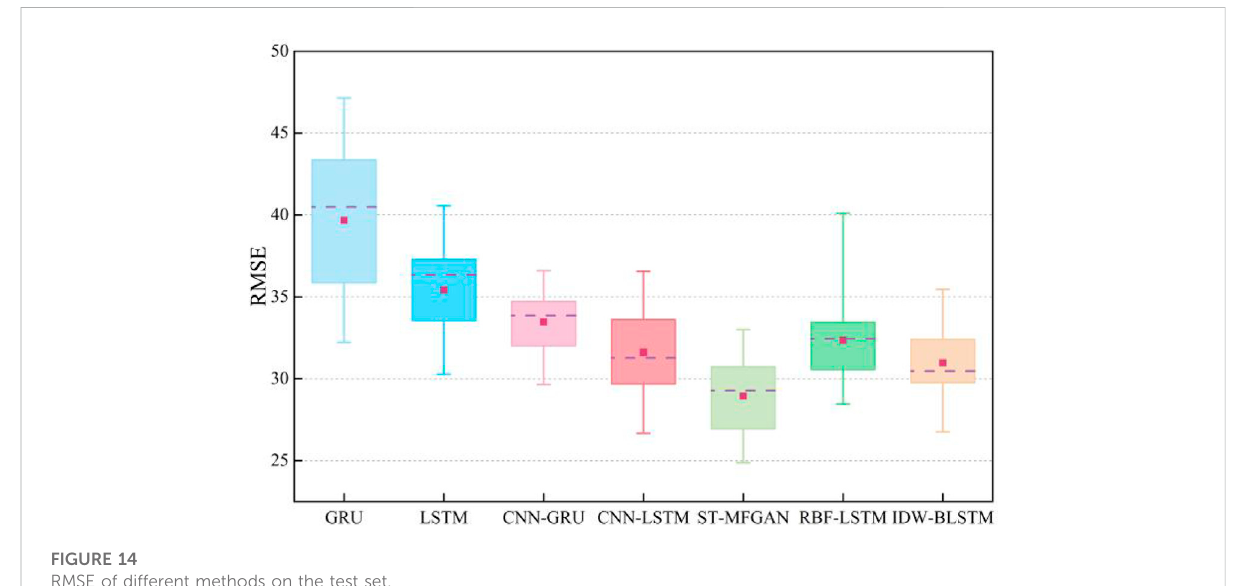
FIGURE 14 RMSE of different methods on the test set.